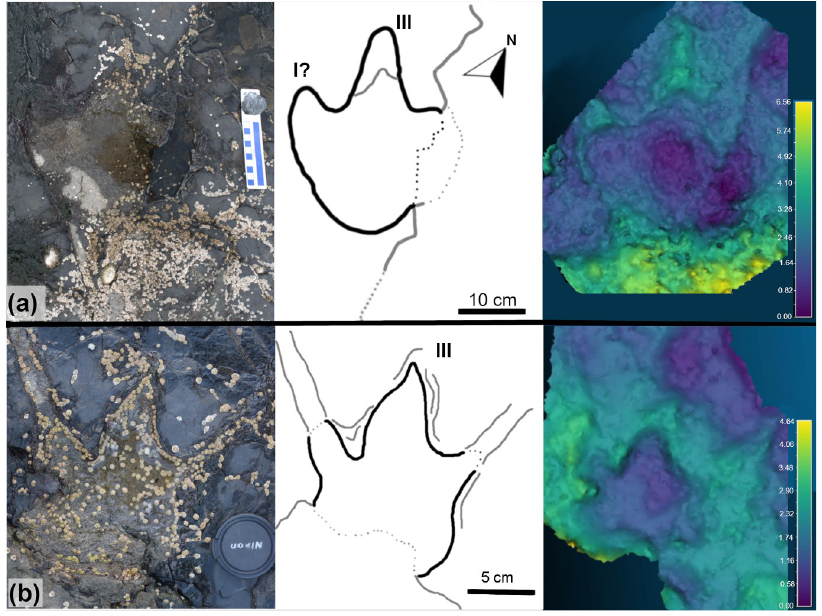
Fig 16. Additional tridactyl track morphologies from BP1. (a) Although broken, BP1_01 (shown with a field photograph, corresponding line drawing, and false color depth map) demonstrates the strongest ornithopod affinity of any of the tracks present at the site. (b) BP1_06 is shown with a field photo, a corresponding line drawing, and a false color depth map. The track preserves strong sediment deformation around the toes and the hypices and desiccation cracks propagate from the lateral digits. These sedimentary features are denoted with light gray outlines on the line drawing. The diameter of the camera lens is 5 cm. The color scale of both false color depth maps is in units of cm.